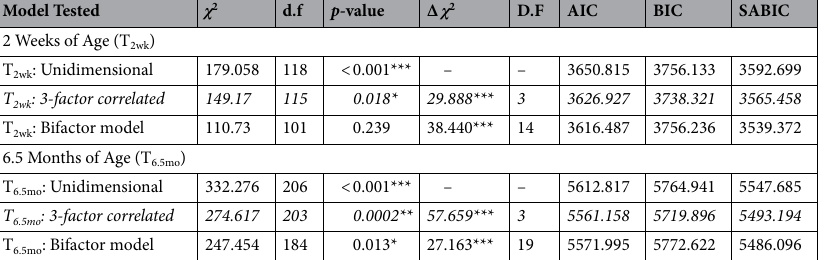
Table 3. Simple structures of miRNAs at neonatal and 6.5-month period and comparison of nested competing models. Italics denote chosen model. AIC, Akaike’s information criterion; BIC, Bayesian information criterion; SABIC, sample-size-adjusted Baysian information criterion; χ 2 , omnibus chi-squared test χ 2 ; d.f., degrees of freedom; Δ χ 2 , chi-squared difference test; Δ D.F. , difference of degress of freedom. P -values are from the omnibus chi-squared test with significance denoted as * p < 0.05; ** p < 0.01; *** p <